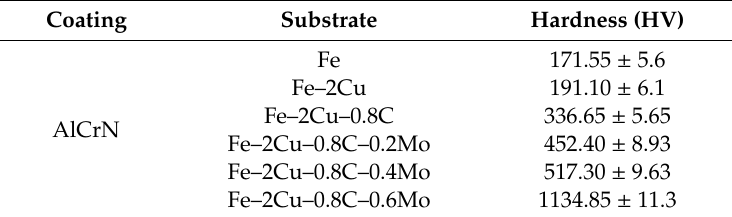
Table 8. Hardness values for the AlCrN coated substrates.